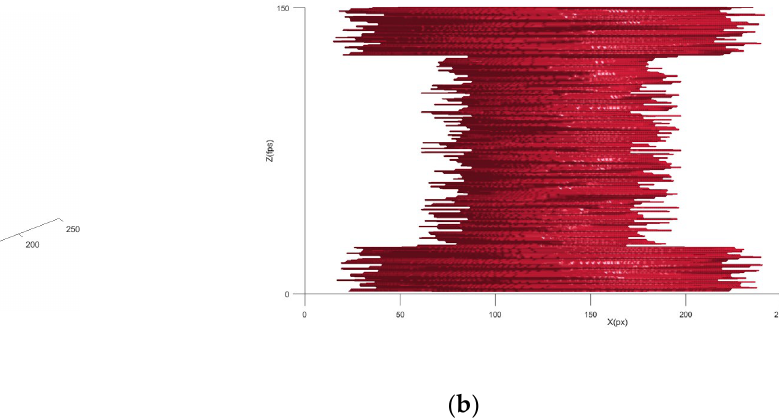
Figure 29. Results of 3D ultrasound reconstruction without speckle decorrelation in DB3 . ( a ) 3D; ( b ) X-Z.